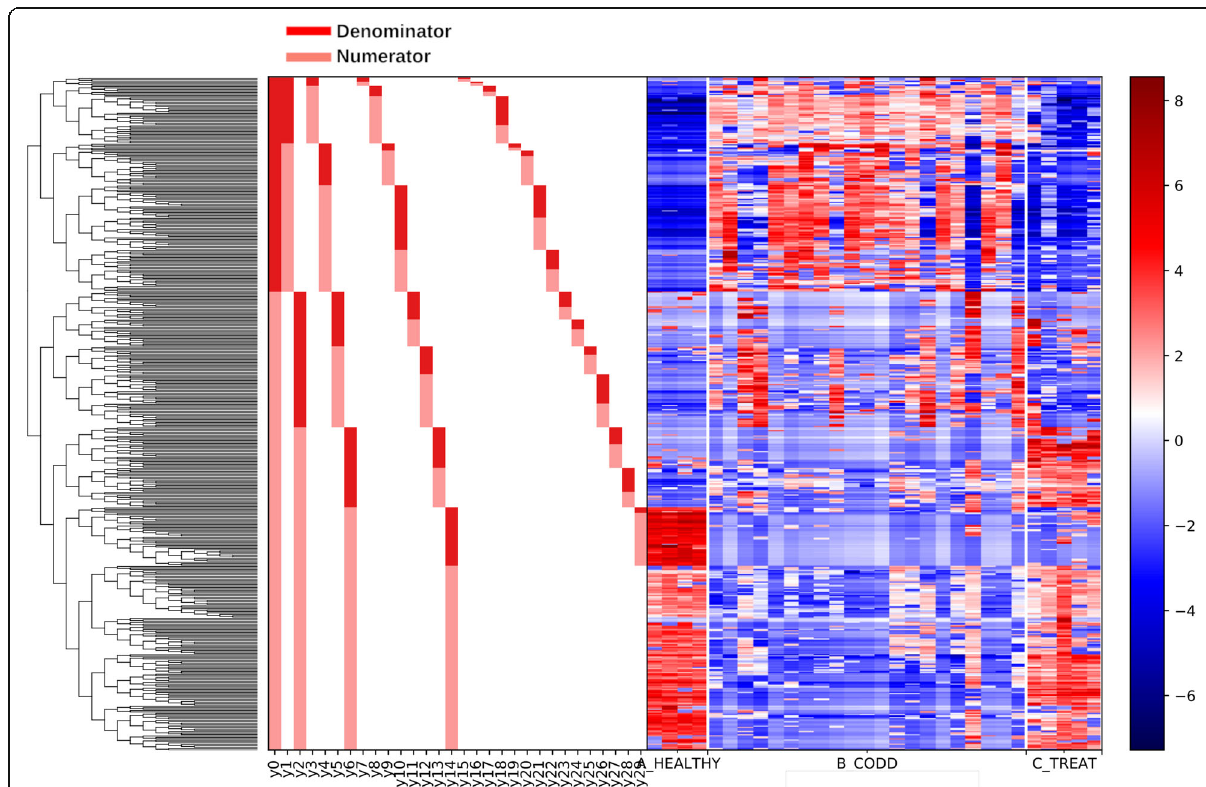
Fig. 9 Dendogram heatmap showing log 10 abundance of ASV in the foot microbiota of samples from healthy (A_Healthy), CODD affected (B_CODD) and antibiotic treated (C_Treated) sheep ’ s